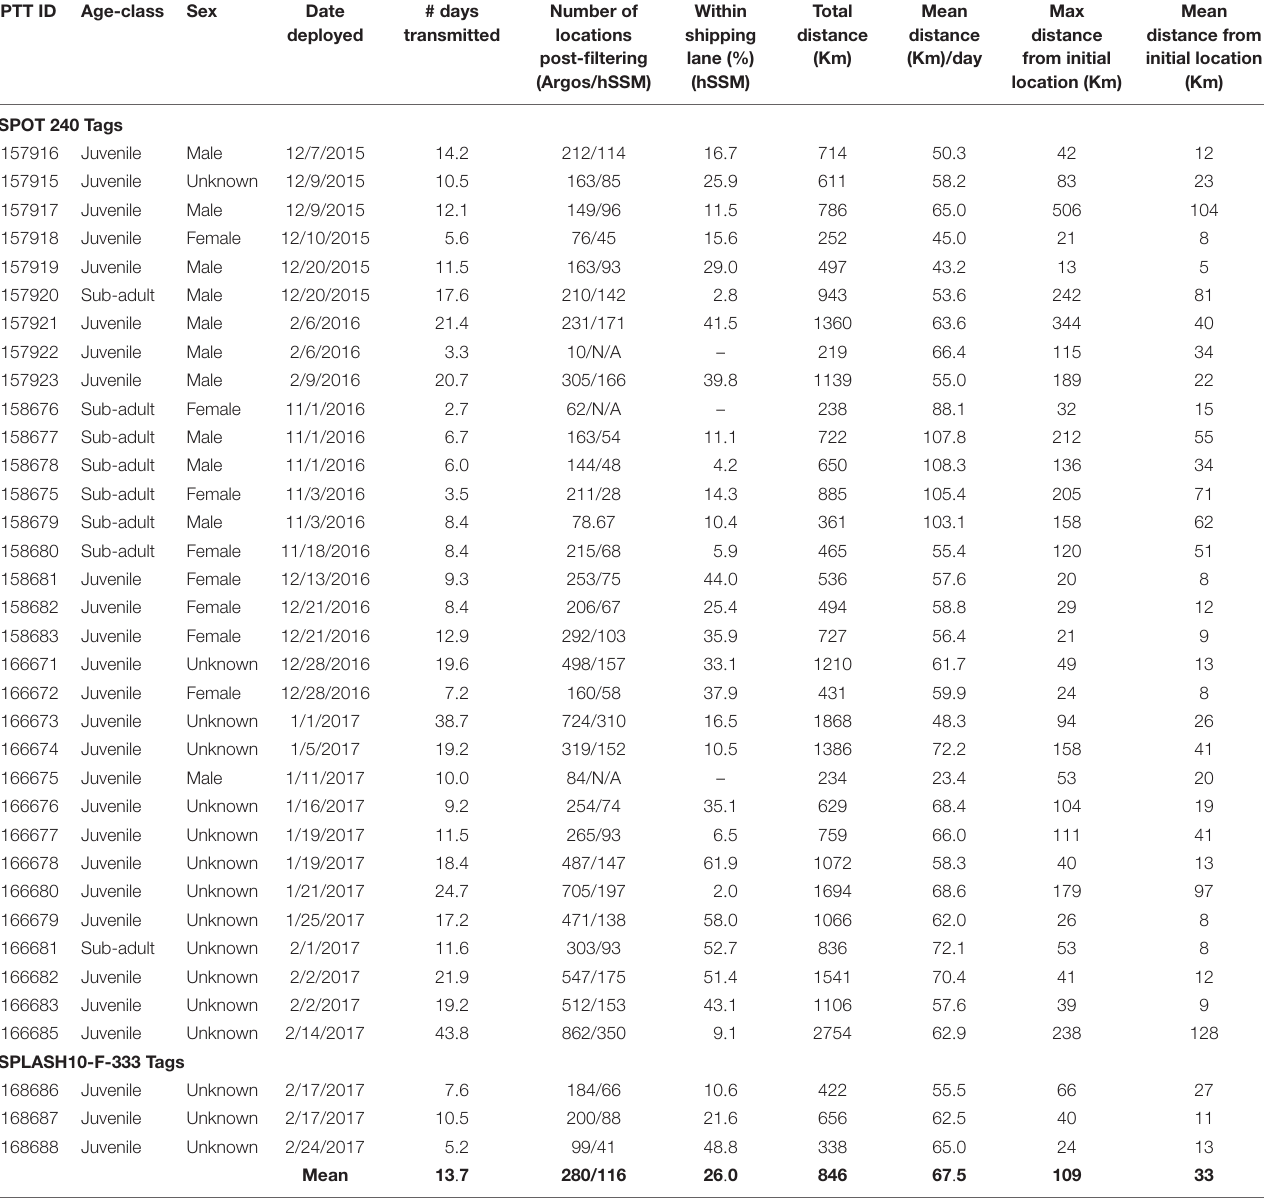
TABLE 2 | Details of satellite tag deployments and results from GIS and hSSM analysis of 35 humpback whales from 2015 to 2017. PTT ID Age-class